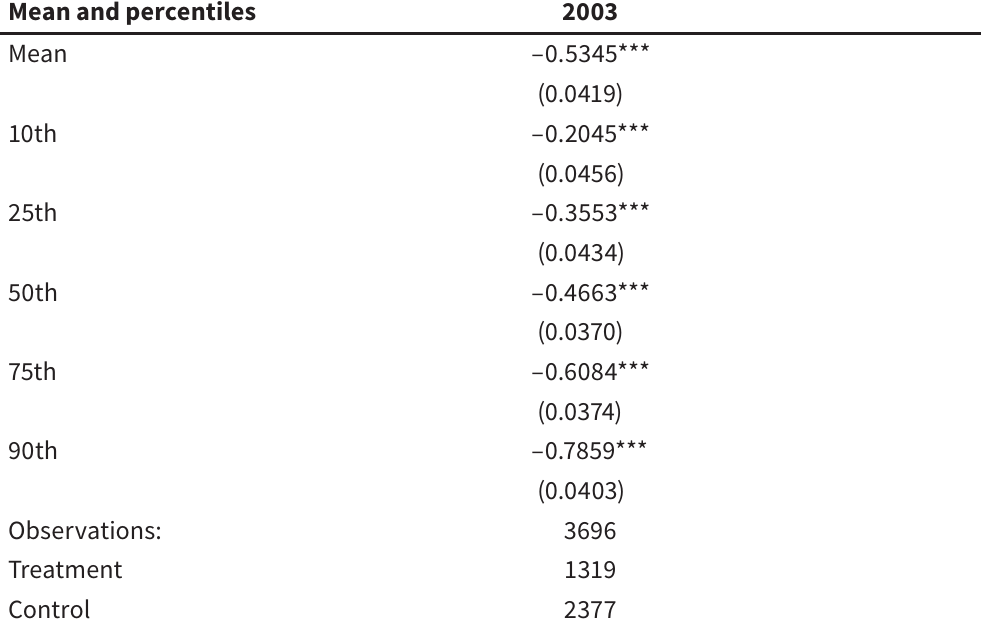
Table A2.9 Log Household Expenditure Differentials between Conflict and Non-conflict Affected Households (Self-reported) at the Mean and Selected Quantiles